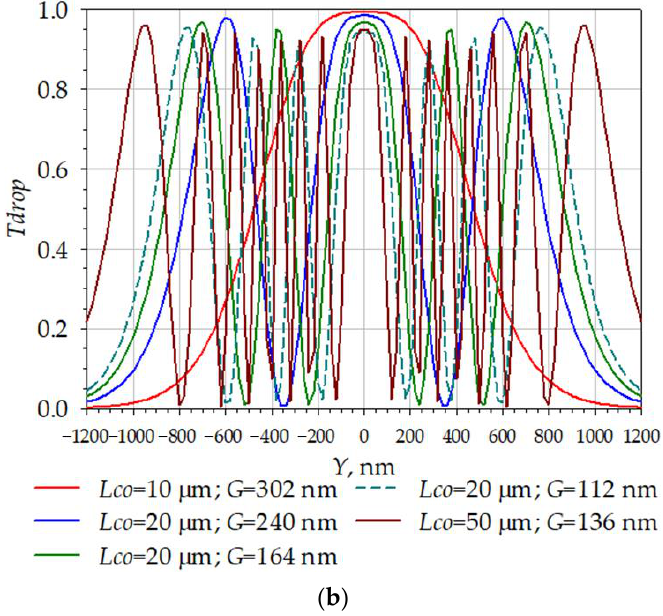
Figure 19. Dependencies of the optical transmission coefficient on the inertial mass linear displace- ment along axis Y for the OMT with different-plane waveguides (Scheme 7). ( a ) Waveguides with dimensions of 300 × 1000 nm; ( b ) Waveguides with dimensions of 300 × 750 nm.